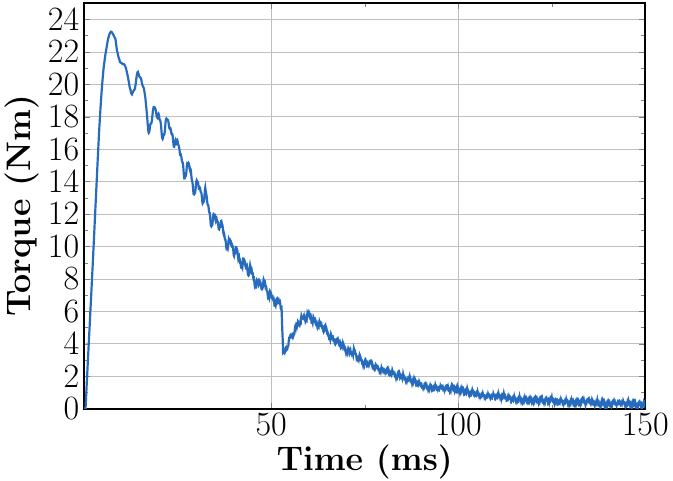
Figure 20. Sensorless speed control for 1200 RPM, torque produced by the synchronous